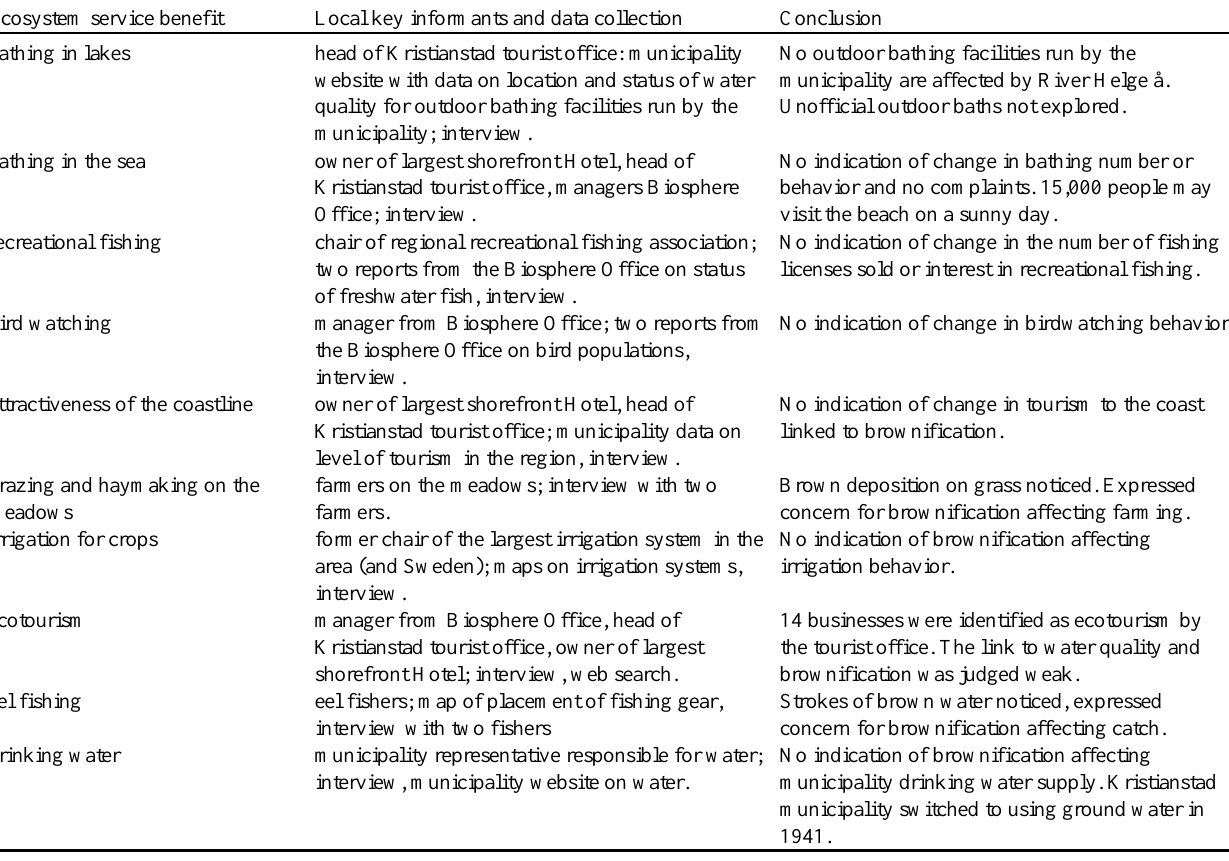
Table 1. A scoping exercise was carried out to identify ecosystem service benefits possibly affected by brownification. Key informants were contacted and data collected. This was done to identify those ecosystem service benefits most likely affected. Two groups of stakeholders were subsequently chosen for further study. We use “ecosystem service benefits” to mean benefits directly used by